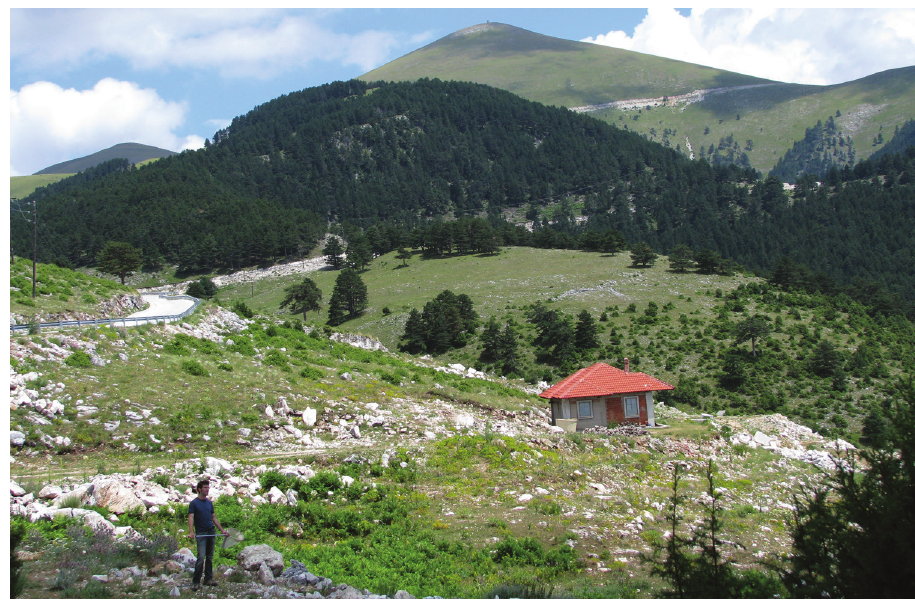
Figure 30. Habitat of P. nephohiptamenos . Northern Greece, Falakro Mt, near Granitis, 1700 m, 24 July 2008. Photo by V.A. Lukhtanov.